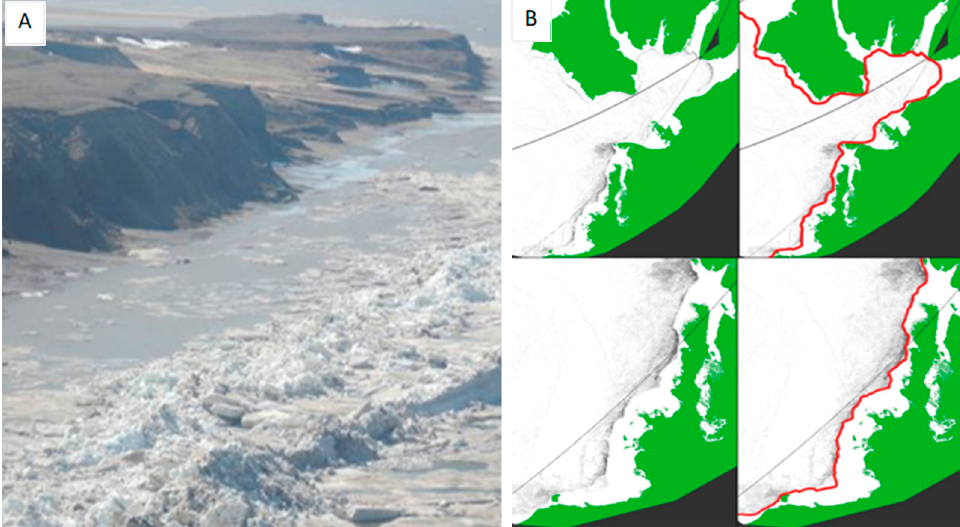
Figure 2. ( A ) Landfast ice during spring break-up along Hooper Island in 2016 along the Beaufort Sea coastline, acting as a barrier to marine erosion. ( B ) Ice occurrence images with the manually delineated landfast ice edge overlaid. Landfast ice edge extents can be seen as dark grey lines in the left-hand side panels relative to the land mask in green. Red lines on the right panels show digitized MLIE.